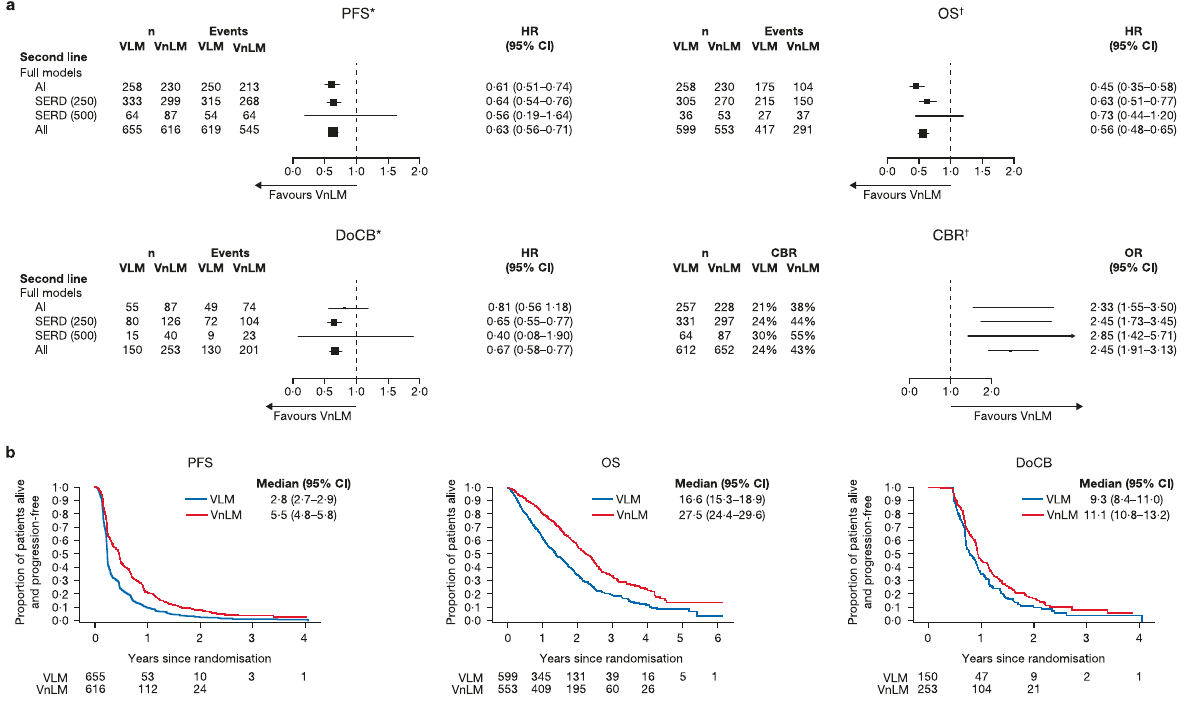
Fig. 6 Clinical outcomes for VLM versus VnLM in the second-line setting. a Forest plots of PFS, OS, DoCB and CBR. * Random effects for trial were fi tted in SERD (500) model. † Fixed effect for trial was fi tted in all models. b Projected probability of PFS, OS and DoCB. Median (95% CI) PFS/OS/DoCB in months. AI aromatase inhibitor, CBR clinical bene fi t rate, DoCB duration of clinical bene fi t, HR hazard ratio, n number of patients, non-VM non-visceral metastases, PFS progression-free survival, OR odds ratio, OS overall survival, SERD selective estrogen receptor degrader, SERM selective estrogen receptor modulator, VLM visceral liver metastases, VM visceral metastases, VnLM visceral non-liver metastases. Statistics for full models: PFS: AI: p < 0·001, heterogeneity test p = 0·12; SERD (250 mg): p < 0·001, heterogeneity test p = 0·93; SERD (500 mg): p = 0·286, heterogeneity test p < 0·05; All: p < 0·001, heterogeneity test p = 0·20. OS: AI: p < 0·001, heterogeneity test p = 0·78; SERD (250 mg): p < 0·001, heterogeneity test p = 0·95; SERD (500 mg): p = 0·212, heterogeneity test p = 1·00; All: p < 0·001, heterogeneity test p = 0·66. DoCB: AI: p = 0·283, heterogeneity test p = 0·66; SERD (250 mg): p < 0·001, heterogeneity test p = 0·90; SERD (500 mg): p = 0·247, heterogeneity test p < 0·05; All: p < 0·001, heterogeneity test p = 0·35. CBR: AI: p < 0·001, heterogeneity test p = 0·72; SERD (250 mg): p < 0·001, heterogeneity test p = 0·98; SERD (500 mg): p = 0·003, heterogeneity test p = 0·17; All: p < 0·001, heterogeneity test p =